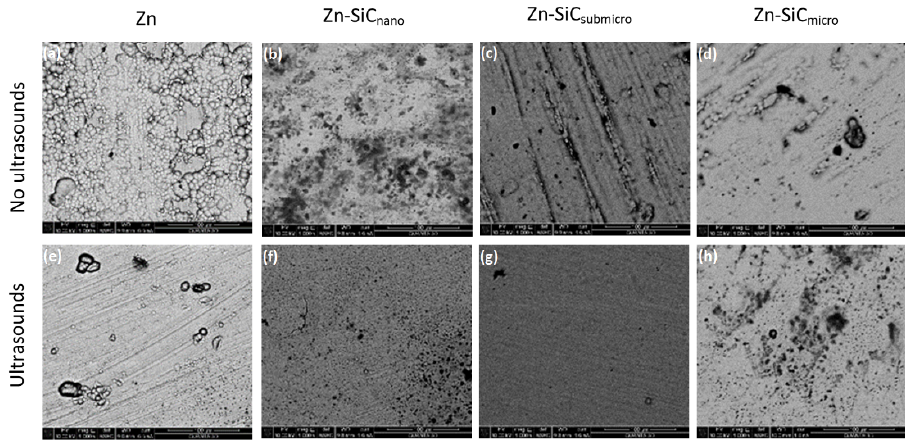
Figure 2. SEM images of Zn and Zn-SiC coatings deposited at 1 A/dm 2 without ( a – d ) and in the presence of ultrasound ( e – h ) (mag.